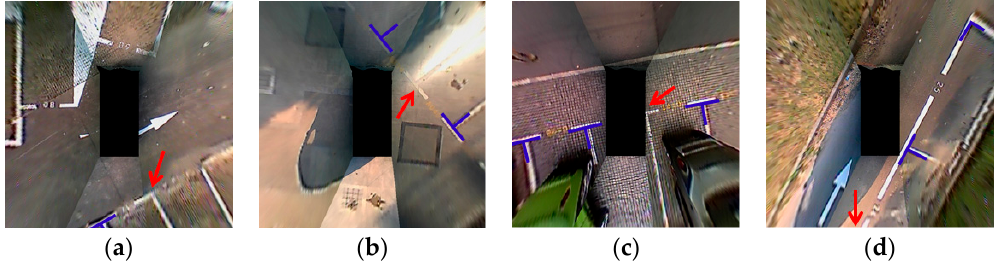
Figure 5. Missed parking slot detections (indicated by red arrows). ( a ) Image distortion. ( b ) Illumination change. ( c ) Occlusion. ( d ) Limited FOV.